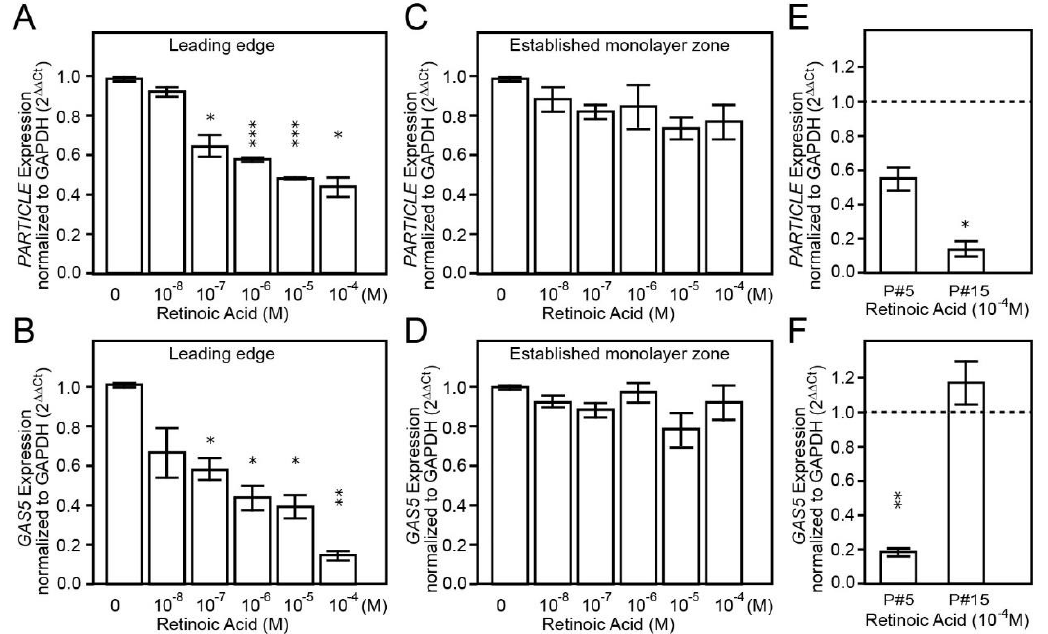
Figure 4. Long non-coding RNA PARTICLE and GAS5 respond to ATRA in U87MG leading edge cells and not in the established cellular monolayer zone with differential passage effects. Histograms of quantitative real time PCR data of PARTICLE and GAS5 showing decreased expression profiles in leading edge cells in response to increased ATRA concentrations ( A , B ). Neither PARTICLE nor GAS5 show differential expression in response to increased ATRA concentrations in the established cellular monolayer zone of U87MG ( C , D ). Histograms highlight reduced levels of PARTICLE with passaging ( E ) in contrast to GAS5 which shows significantly elevated expression in later passages ( F ). Asterisks represents p < 0.05 significance, n = 3.